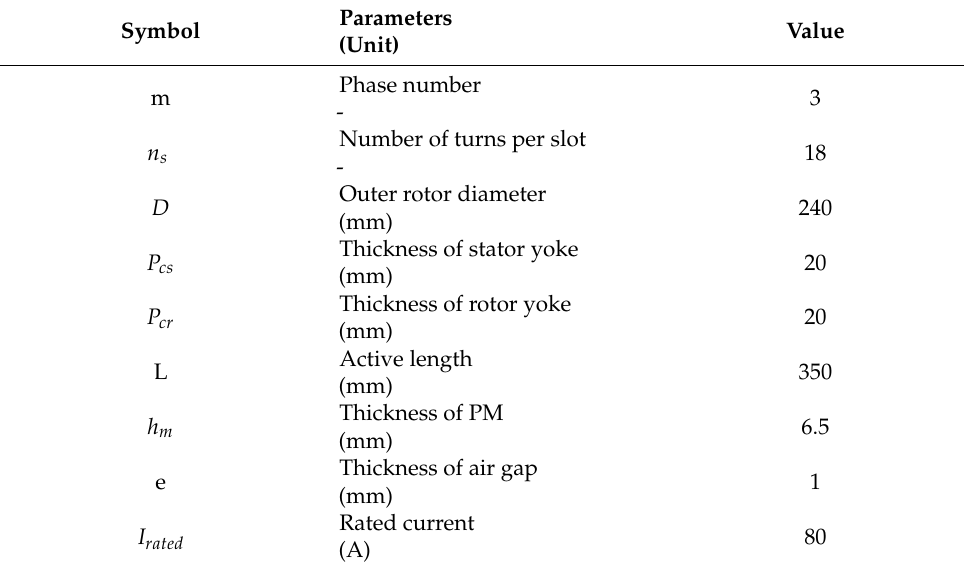
Table 4. Main geometric parameters of the prototype drive.